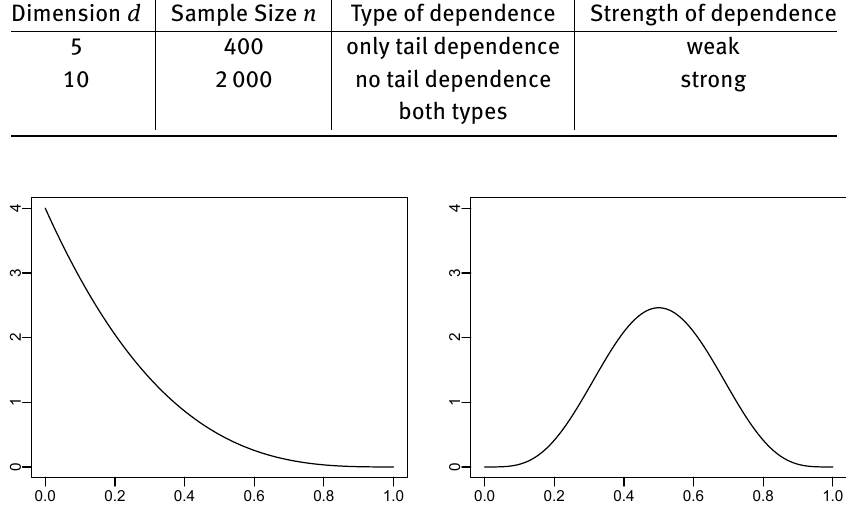
Figure 2: Densities for the simulation of absolute Kendall’s τ in the scenarios with weak (left) and strong (right)